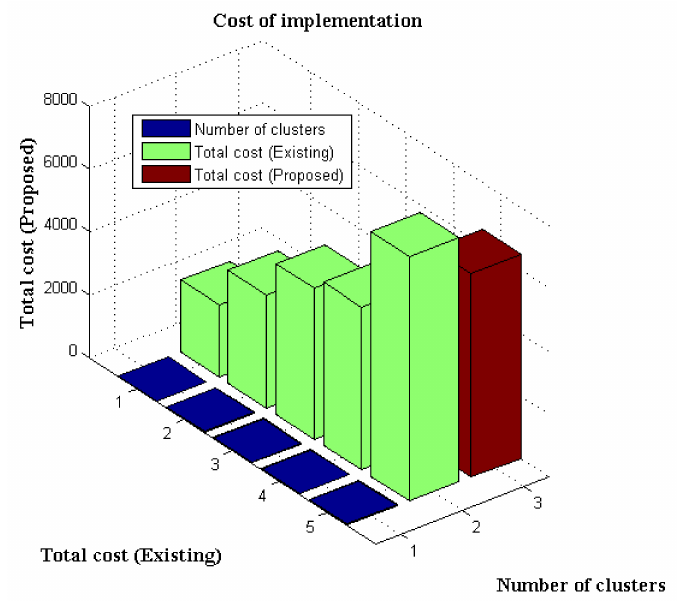
Figure 7. Imperial cost of comparison with cluster nodes.